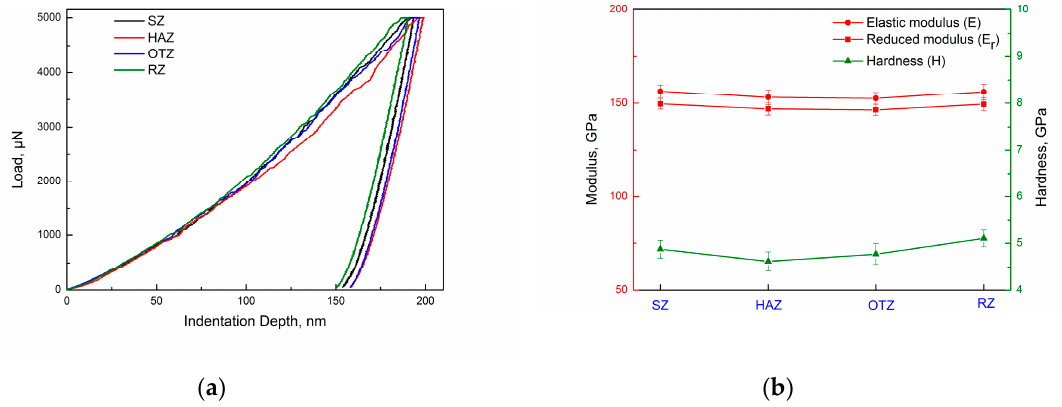
Figure 15. ( a ) Nanoindentation load–depth curves and ( b ) indentation modulus and hardness data of the matrix phase in different zones of the LARed samples.